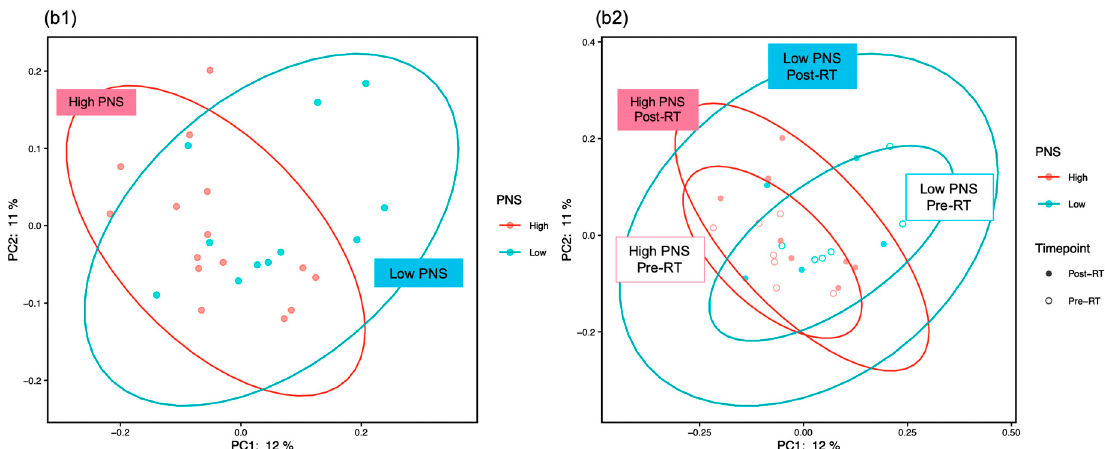
Figure 2. The β -diversity of gut microbiome by PNS level (low vs. high) pre-RT, post-RT, or the combination of both. ( a1 ) and ( b1 ) display the dissimilarities of gut microbiome via PNS levels (low vs. high) using the Bray-Curtis and weighted UniFrac distance. ( a2 ) and ( b2 ) display the dissimilarities of gut microbiome via PNS levels (low and high) vs. timepoint (pre-RT and post-RT) using Bray-Curtis and weighted UniFrac distance. PNS, psychoneurological symptoms; RT, radiation therapy.